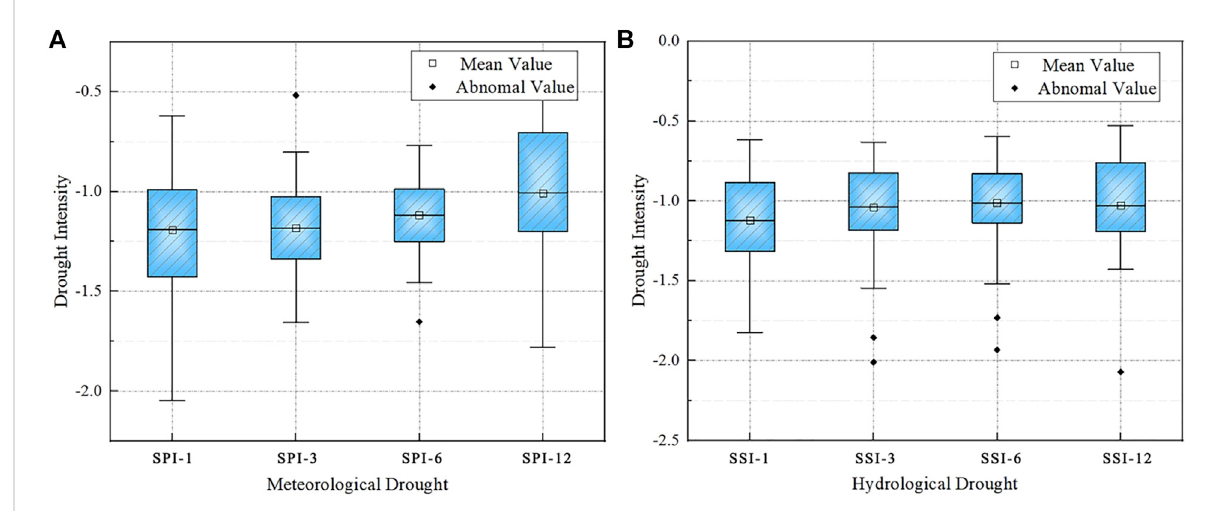
FIGURE 5 Intensity characteristic of (A) meteorological drought and (B) hydrological drought at different